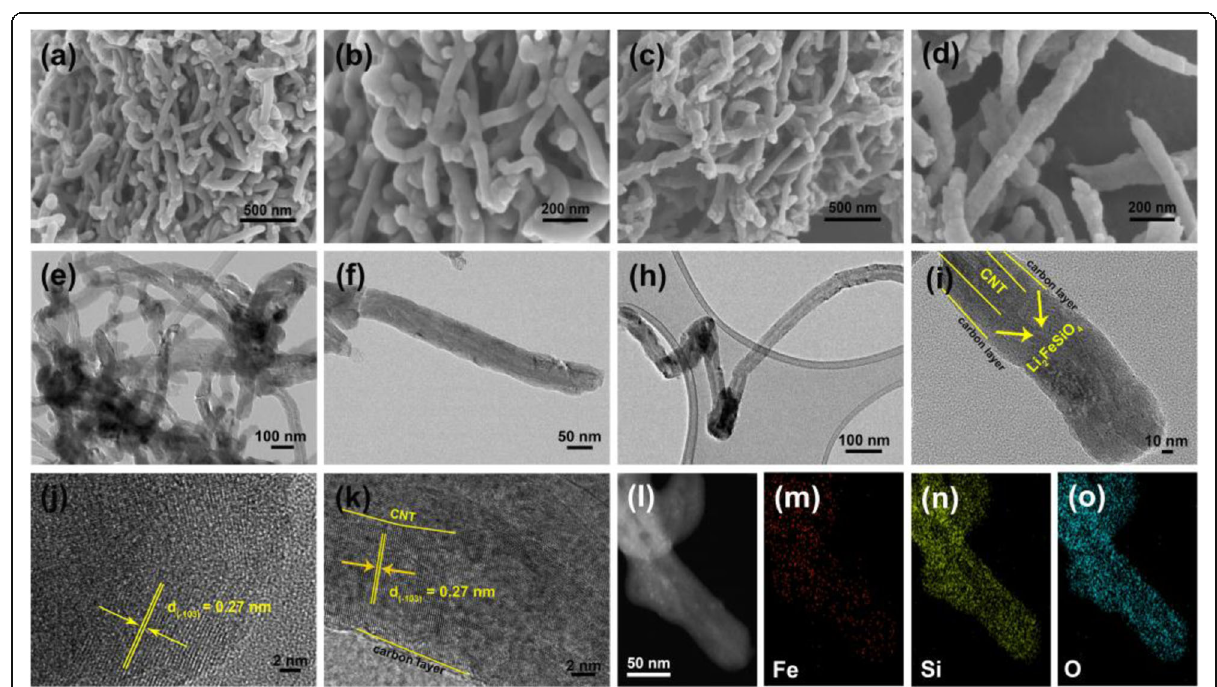
Fig. 3 a , b SEM images of CNT@Li 2 FeSiO 4 , c and d SEM images of CNT@Li 2 FeSiO 4 @C. e and f TEM images of CNT@Li 2 FeSiO 4 , h and i TEM images of CNT@Li